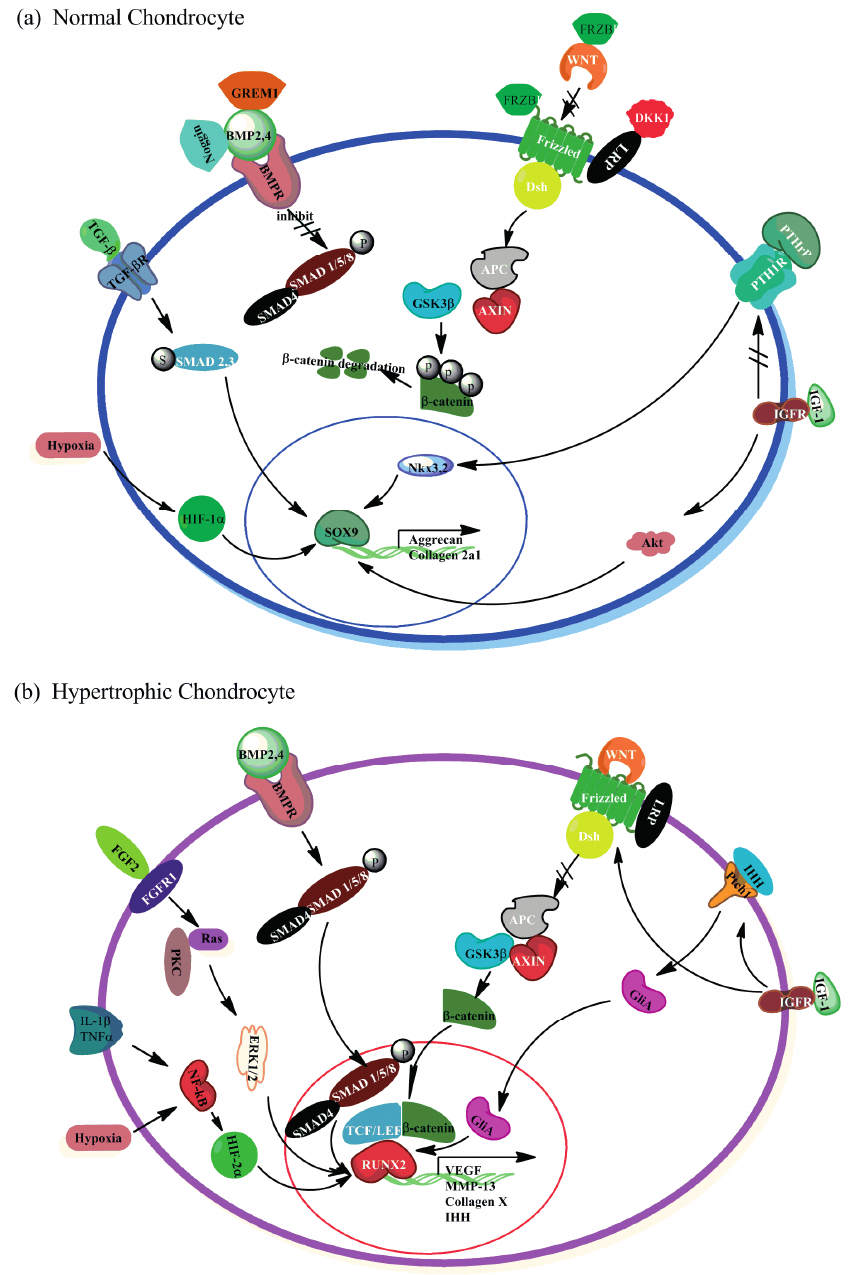
Figure 2. Signal pathways of chondrocyte hypertrophy. ( a ) In normal chondrocytes, signal pathways like WNT, BMP, IHH, etc. are regulated by their antagonists (DKK1 and FRZB for WNT, GREM1 for BMP) or other signal factors to get a fine balance to maintain the chondrocyte normal phenotype. The most important transcription factor regulating chondrocytes is SOX9, which is responsible for the expression of main chondrocyte makers including collagen type II and aggrecan. Striked through arrows indicate that the signaling pathway is inhibited by its antagonists; ( b ) In hypertrophic chondrocytes, signal pathways, such as WNT, BMP, IHH, etc. are deregulated by their inhibitors or other signal factors, which consequently leads to overexpression of these pathways. Subsequently, the effects of cascade pathways result in activating the transcription factor RUNX2, which regulates the transcription of hypertrophic markers like collagen X, MMP-13, VEGF and